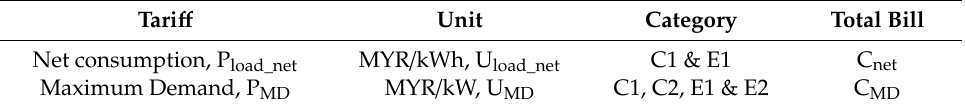
Table 3. Tari ff rates under Malaysian utility billing